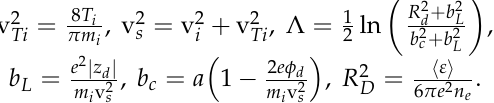
v g —thermal velocity of gas atoms: v g =